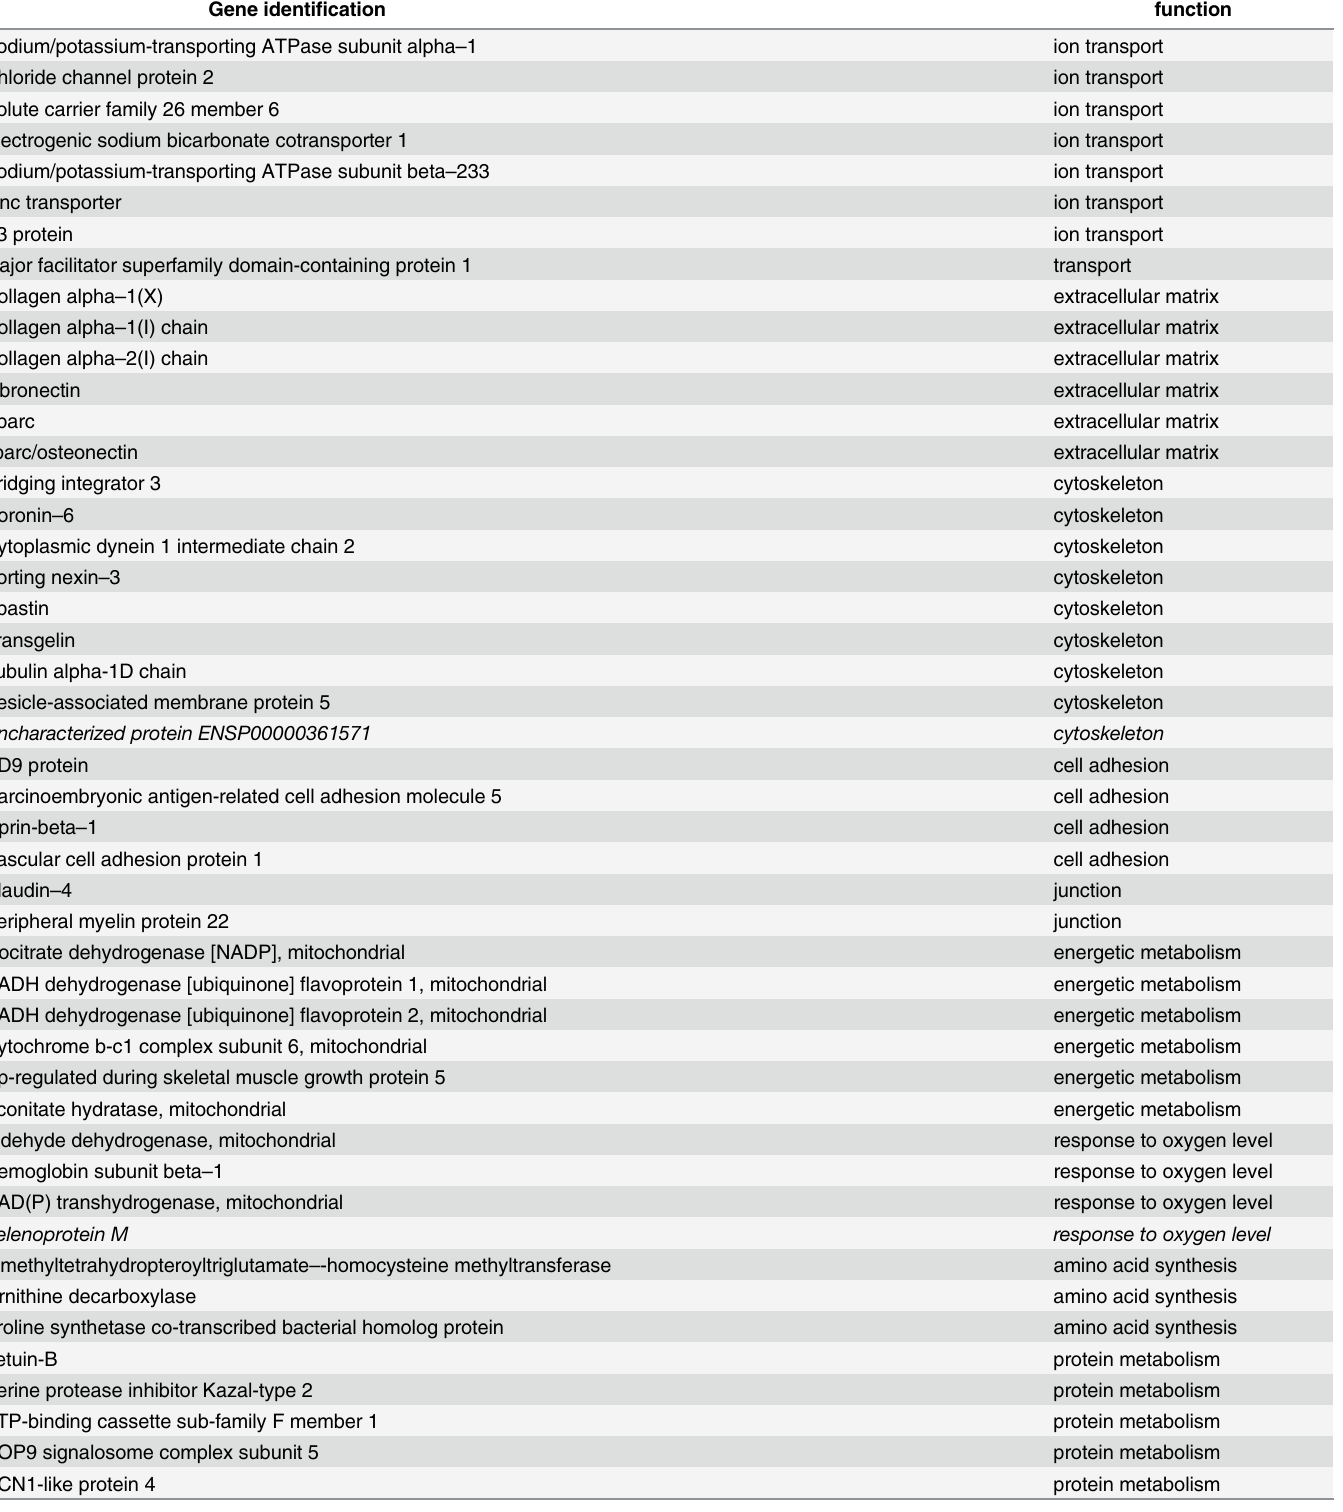
Table 2. Annotated genes exhibiting differential expression between FW and SW